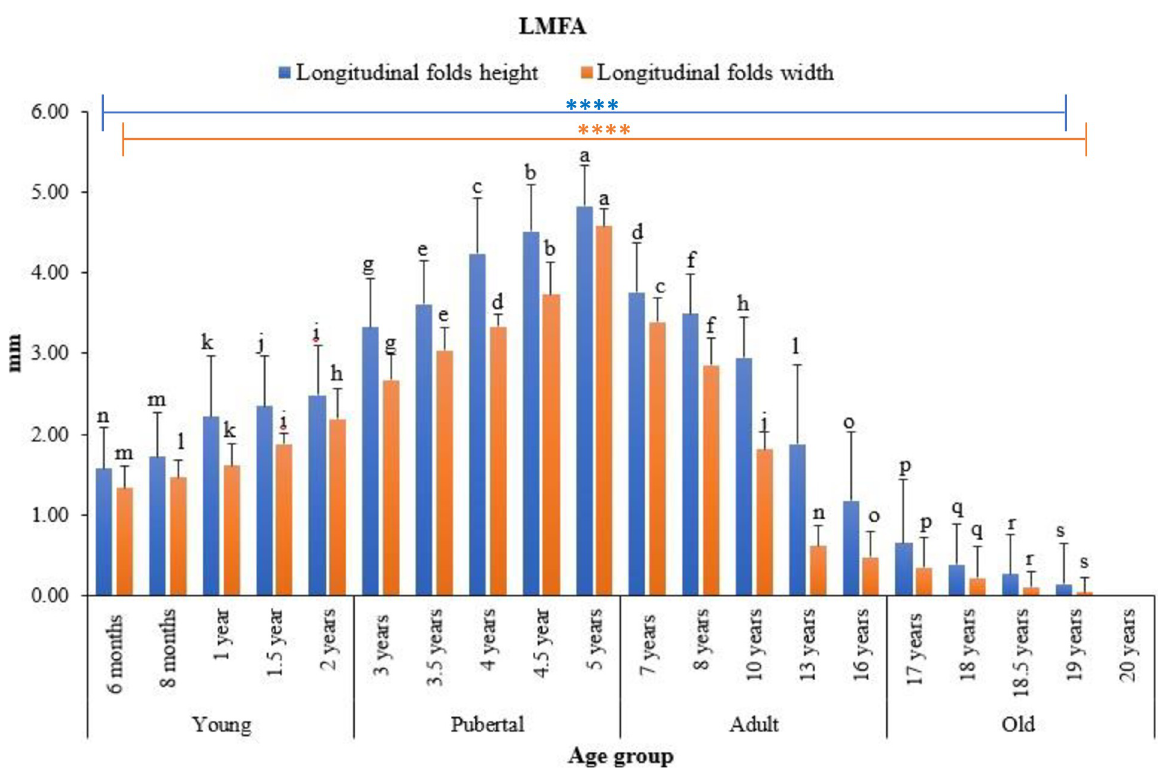
Fig 5. Differences in height and width of the longitudinal mucosal folds of ALNA between age groups of dromedary camels. Data are expressed as means (n = 3). Error bars represent standard deviation. Bars with a different letter are significantly different (one-way ANOVA with Duncan’s multiple range test, p < 0.05). ���� represents significance at p < 0.0001. LMFA: longitudinal mucosal fold